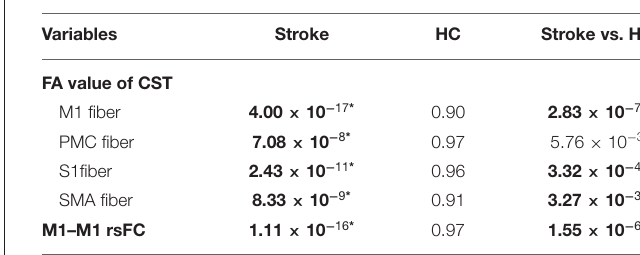
FIGURE 2 | CSTs with different origins. (E) Shows the longitudinal evolutionary trajectories of M1–M1 rsFC. The thin red (stroke) and blue (HC) lines represent the individual changes over time and the thick red and blue lines indicate the estimated average changes in the two groups. CST, corticospinal tract; FA, fractional anisotropy; HC, healthy controls; M1, primary motor cortex; PMC, premotor cortex; rsFC, resting-state functional connectivity; S1, primary sensory area; and SMA, supplementary motor area.